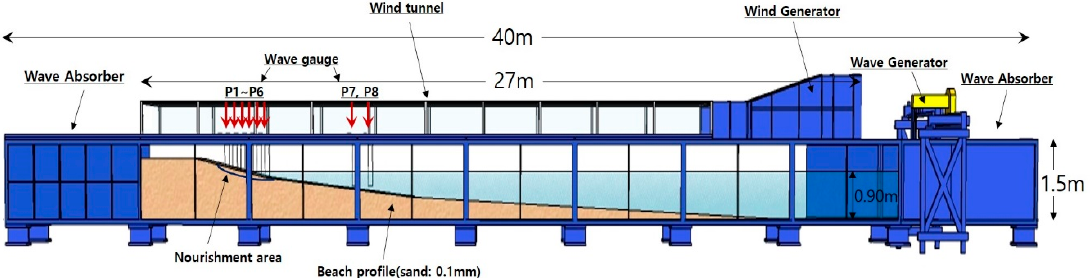
Figure 1. Experimental setup condition with wind–wave flume.